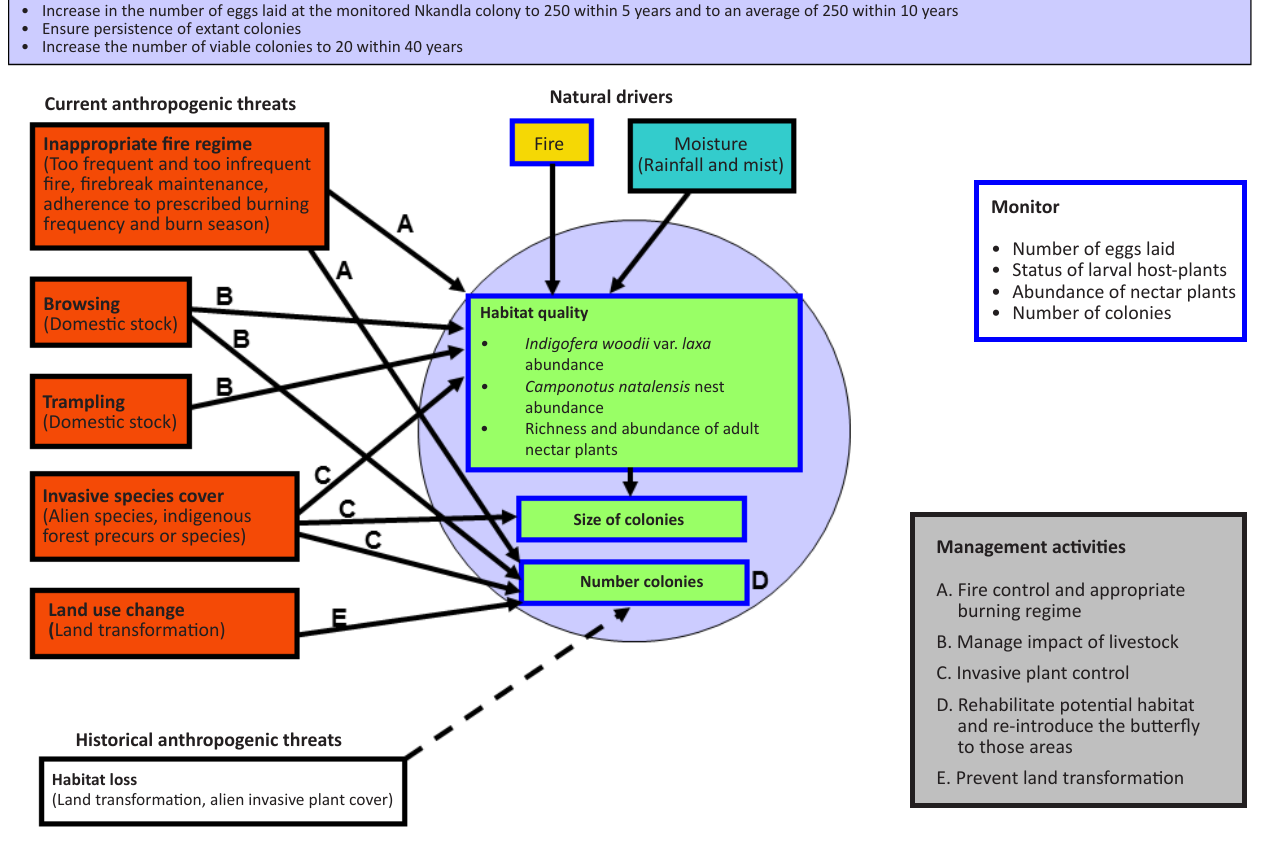
Red boxes indicate anthropogenic threats, the white box indicates a historical anthropogenic threat, the purple circle indicates the butterfly, green boxes indicate ecological variables that should be measured during monitoring to evaluate whether the goals are being met and the response to management. Boxes outlined in blue indicate variables that should be measured during monitoring. The grey box indicates management activities, where the letters indicate which process each would affect. FIGURE 3: Conceptual model for the management and monitoring of Orachrysops ariadne